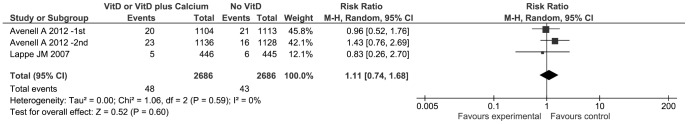
Forest plot of vitamin D supplementation and breast cancer incidence.Legend to Figure 3. M–H, Mantel-Haenszel; 95% CI, 95% confidence interval; df, degrees of freedom.